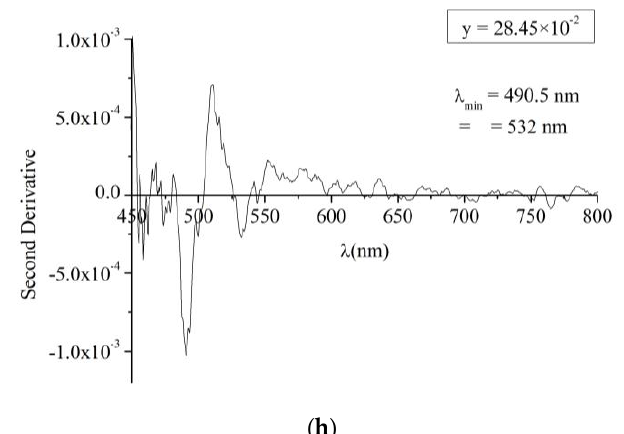
Figure 7. The second derivative of the absorbance against the wavelength of incident radiation for a CdS:In film ( a ); and CdS 1−y Te y thin films of different composition ( b – h ).